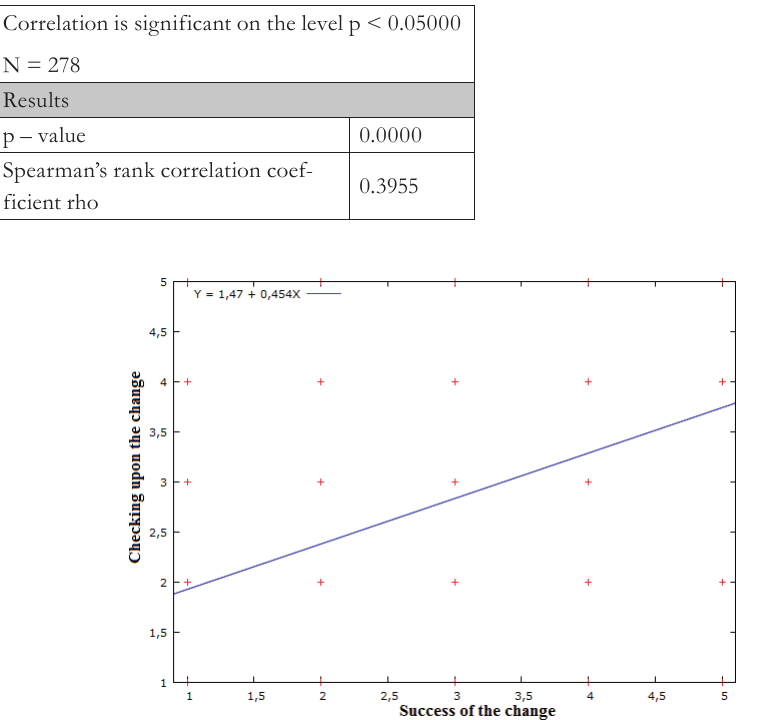
Fig. 4 - X – Y chart: Testing results of the third hypothesis. Source: Own processing using